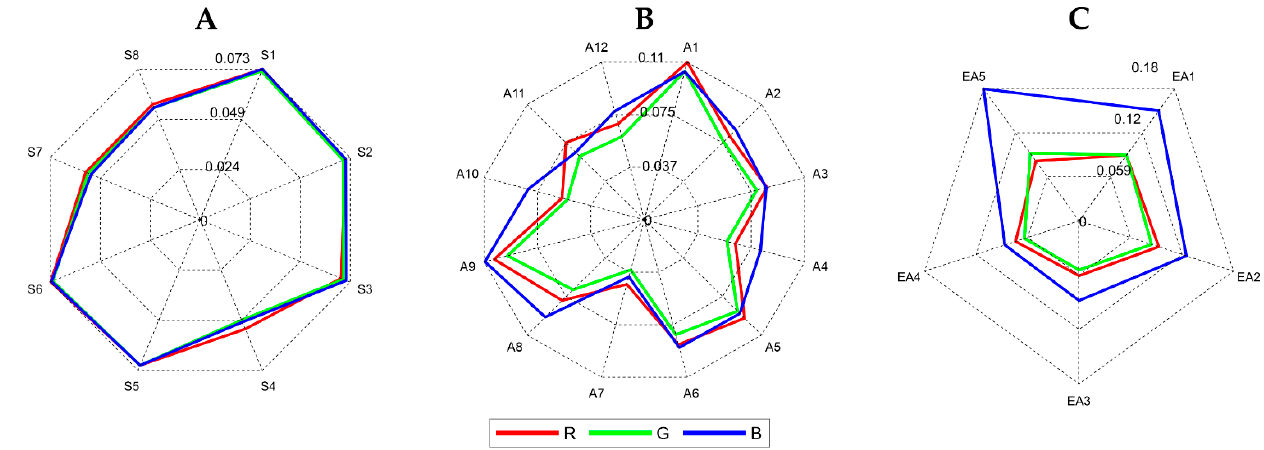
Figure 4. Radar plots for analyzed tequila samples with their respective absorbance values. ( A ) Silver, ( B ) Aged, and ( C ) Extra-aged.